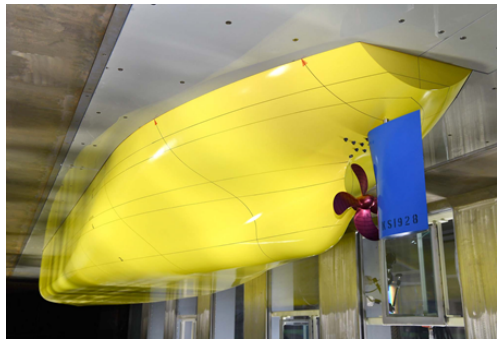
Figure 4. Model ship installed in the LCT.